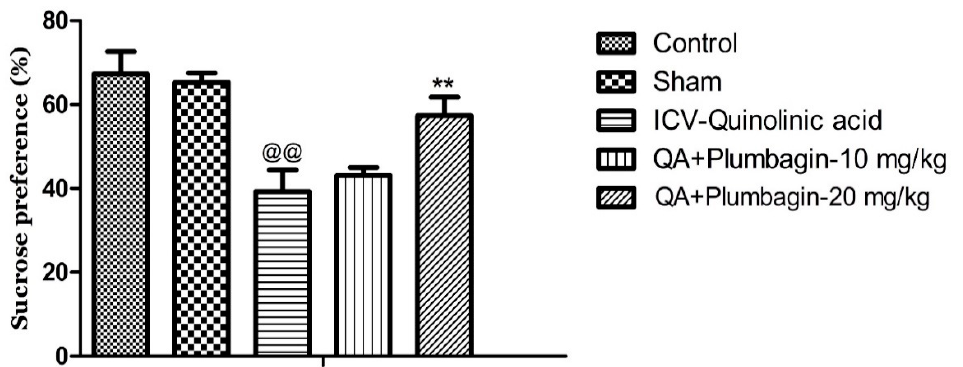
Figure 3. Effect of plumbagin on QA-provoked decline in percent of sucrose preference during the Sucrose Preference Test. Data represent mean ± SEM ( n = 6). @@ p < 0.01 as compared to control group; ** p < 0.01 as compared to QA-administered group.